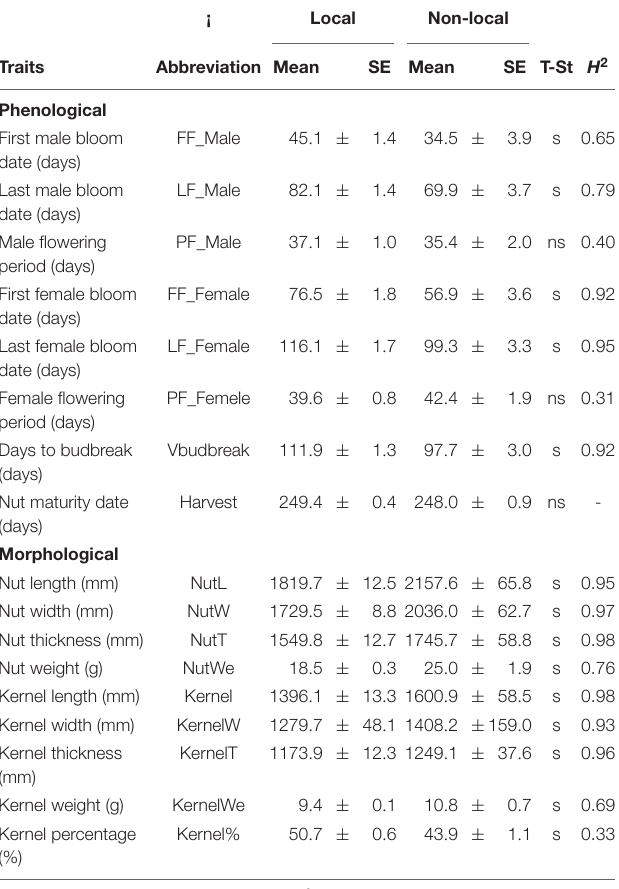
TABLE 2 | Means and standard errors (SE) for phenological and morphological traits evaluated in local and non-local hazelnut accessions at SERIDA in Villaviciosa,